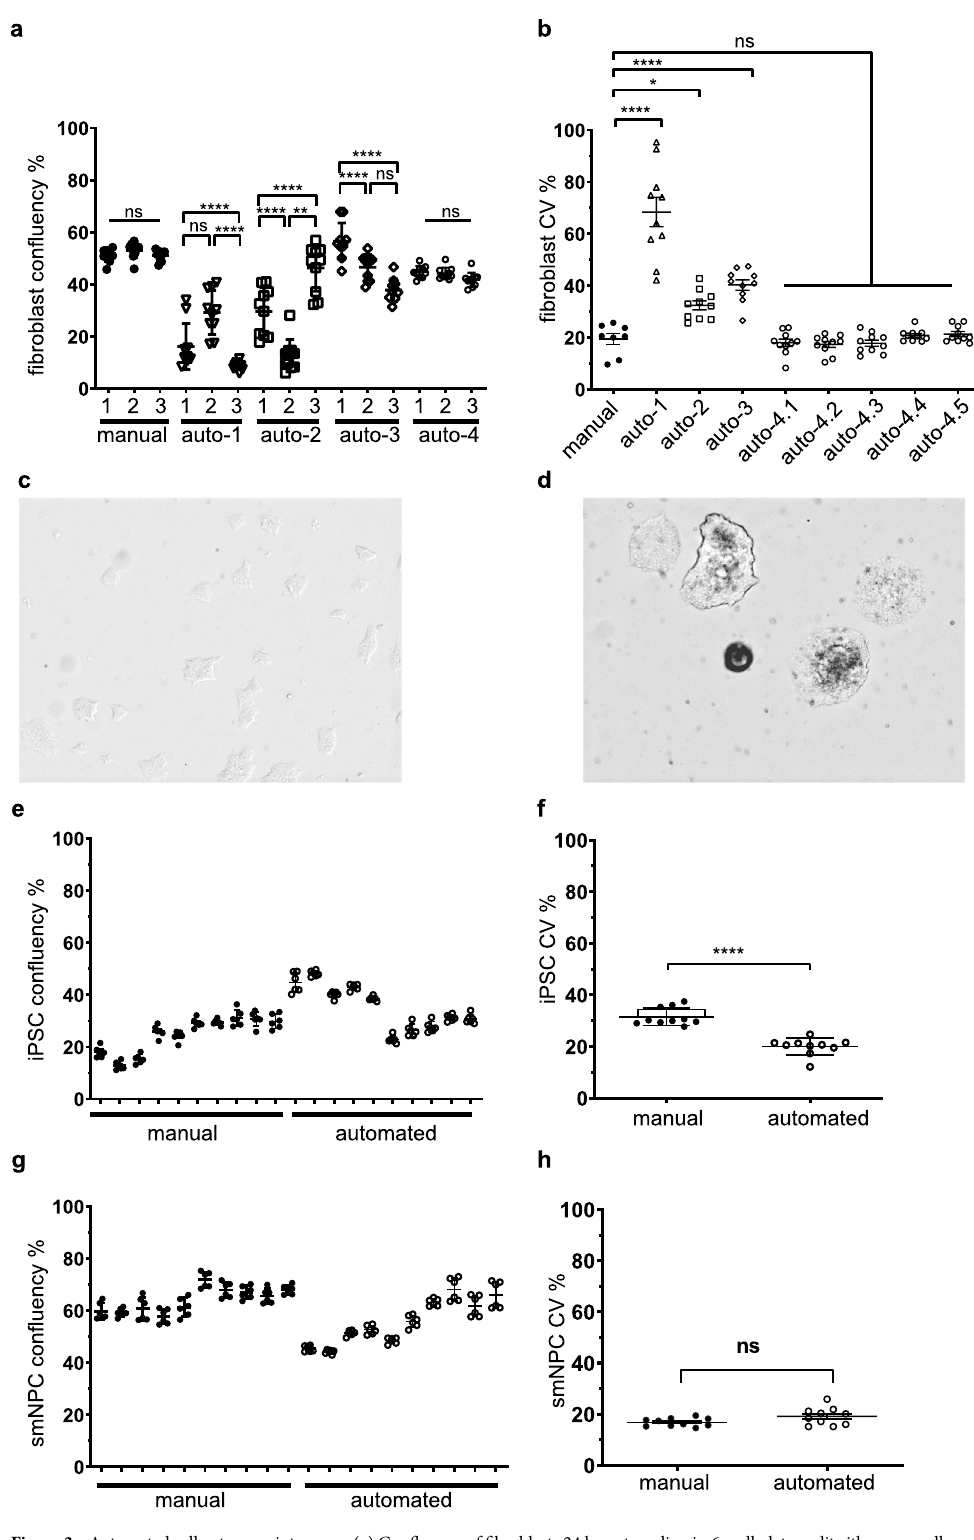
Figure 3. Automated cell cuture maintenance. ( a ) Confluency of fibroblasts 24 h post seeding in 6-well plates split either manually or with automated methods 1, 2, 3, or 4 into three destination wells. n = 10 statistical test used: one-way ANOVA with addhoc Tukey’s test. ( b ) CV of fibroblasts 24 h post seeding in 6-well plates split either manually or with automated methods 1, 2, 3, or 4 into three destination wells. After passaging with method 4 plates were either left unshaken (4.1) or shaken for 1 min (4.2) or 5 min (4.3) with a linear shaker, 3 min with an orbital shaker (4.4), or pivoted with the tilting station for 3 min (4.5). n = 10 statistical test used: one-way ANOVA with addhoc Sidak’s test. ( c , d ) Representative image of iPSC 24 h post splitting with EDTA ( c ), or dispase ( d ). ( e ) Confluency of 20 6-well plates of iPSC 24 h after splitting them either manually or with the automated method 1:7. ( f ) CV of iPSC from (e) n = 10 statistical test used: Mann–Whitney test. ( g ) Confluency of 20 6-well plates of smNPC 24 h after splitting them either manually or with the automated method 1:7. ( h ) CV of smNPC from (f) n = 10 statistical test used: Mann–Whitney test. *p < 0.05, **p < 0.01, ***p < 0.001, ****p <